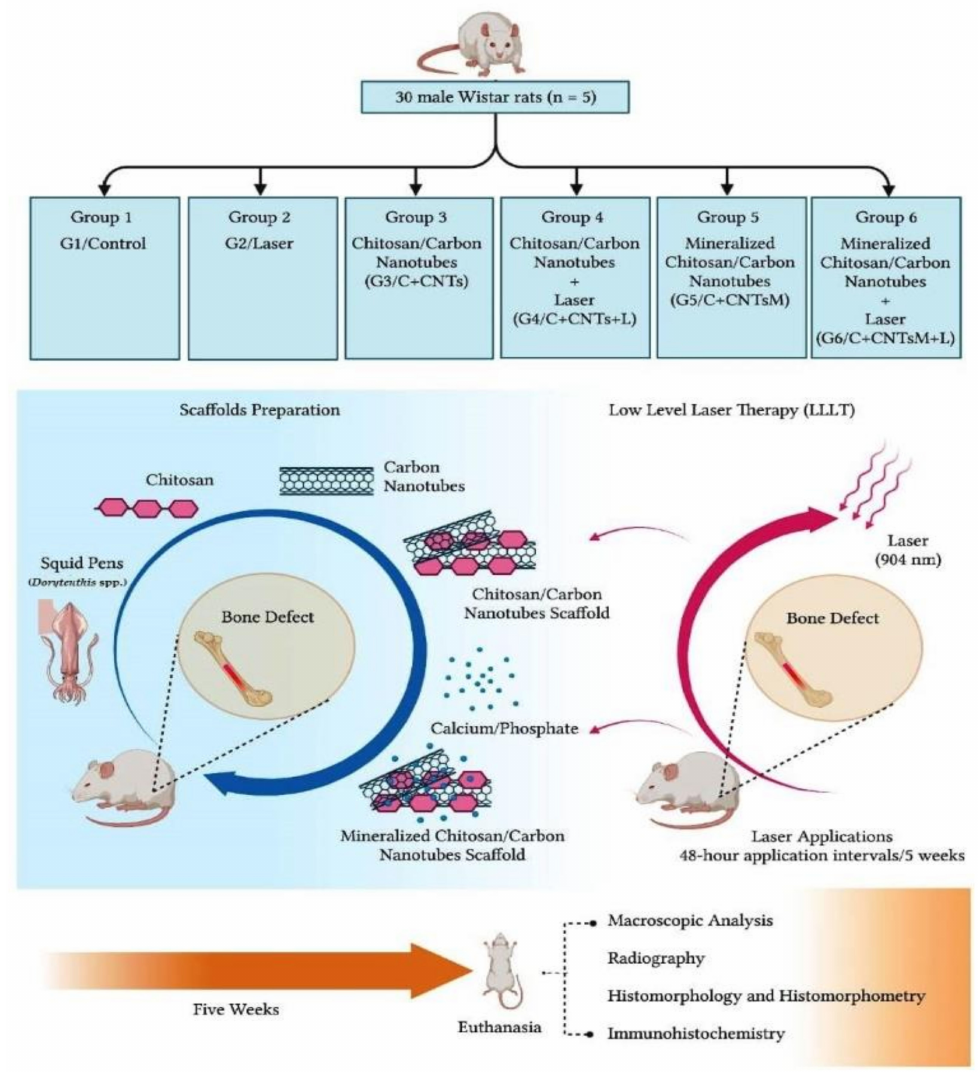
Figure 12. Design of the study groups and preparation of the scaffolds. Thirty male Wistar rats were divided into 6 groups: Control (G1/Control), Laser (G2/Laser), Chitosan and Carbon Nanotubes (G3/C+CNTs), Chitosan/Carbon Nanotubes/Laser (G4/C+CNTs+L), Mineralized Chitosan/Carbon Nanotubes (G5/C+CNTsM), Mineralized Chitosan/Carbon Nanotubes/Laser (G6/C+CNTsM+L). Analyses were performed after 5